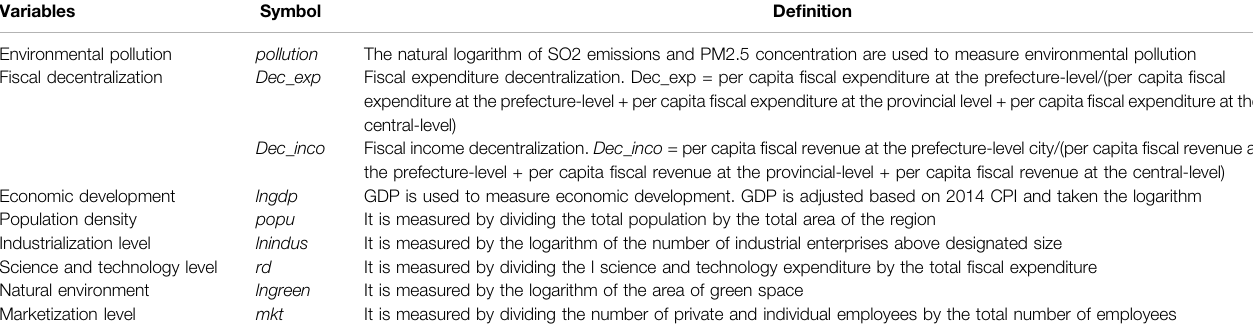
TABLE 1 | Variable de fi nitions.